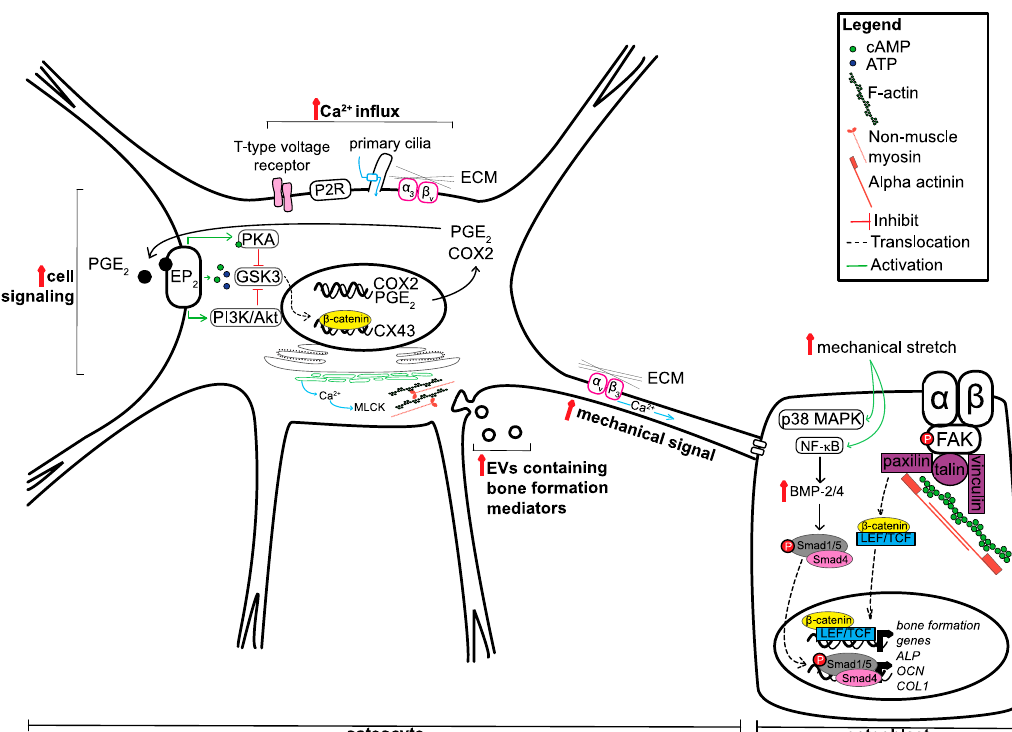
Figure 1. Summary of mechanisms utilised by osteocytes and osteoblasts to respond to mechanical cues. Although both osteocytes and osteoblasts utilise similar mechanisms to respond to mechanical cues, the primary outcome is not the same. Osteocytes respond to mechanical stimuli by increasing secondary messengers and the mechanical signals for neighbouring cells, including osteoblasts. Osteoblasts utilise these signals to increase the expression of genes involved in bone formation through the translocation of various transcription factors, mediated by signalling pathways and mechanically responsive